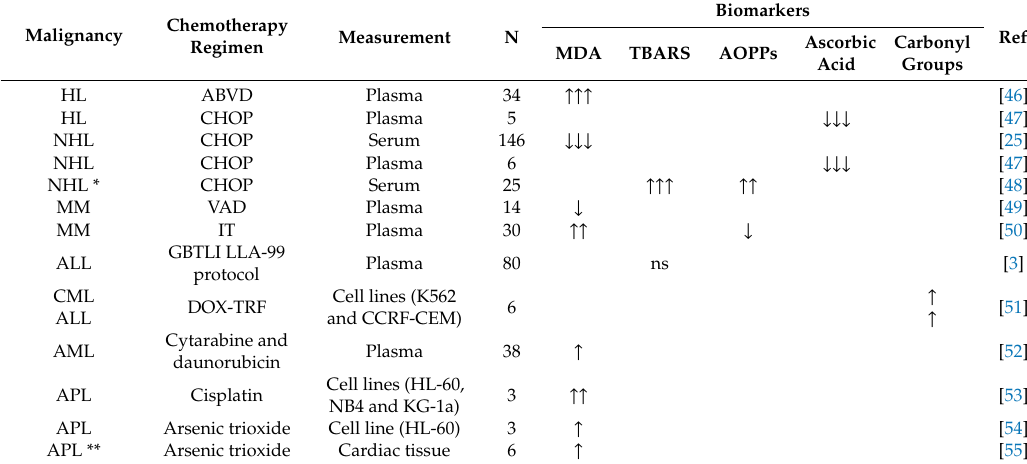
Table 2. Major protein carbonylation and lipid peroxidation biomarker levels identified in patients with hematological malignancies or in preclinical models after chemotherapeutic treatment.